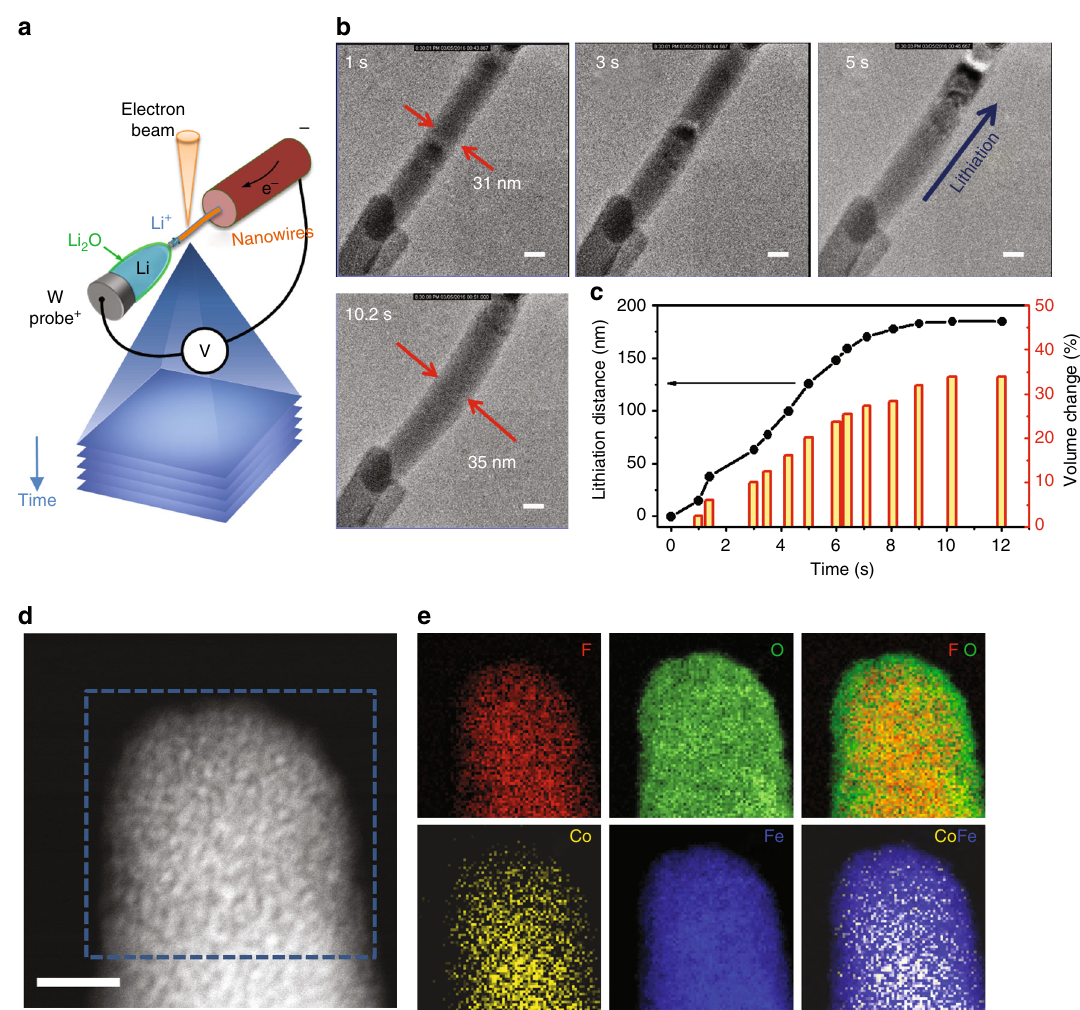
Fig. 4 Structure conversion of Fe 0.9 Co 0.1 OF nanorod monitored in real time and the elemental composition distribution. a Schematic illustration of the electrochemical setup for in situ TEM test. b In situ HRTEM image of Fe 0.9 Co 0.1 OF during dynamic lithiation at 1.2 V for different time. c The lithiation distance and the volume change as function of time. d ADF-STEM image and e corresponding Fe, Co, O, and F elemental distributions after the fi rst lithiation obtained by STEM-EELS technique. Scale bar in b and d is 20 and 10 nm,